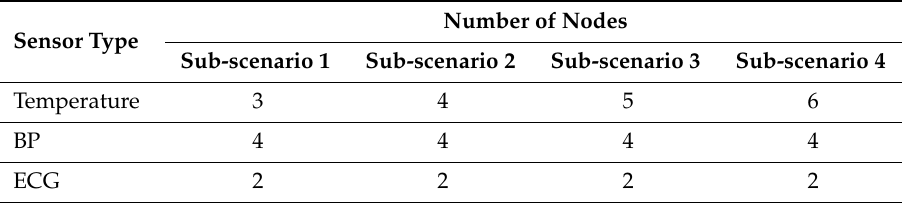
Table 6. Deployment of sensors in Scenario 3.